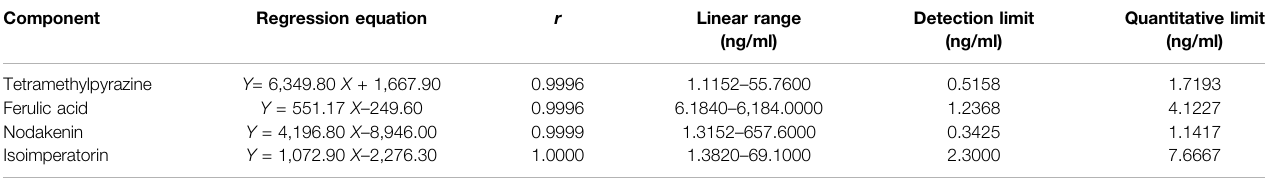
TABLE 4 | Recovery of tetramethylpyrazine, ferulic acid, nodakenin, isoimperatorin in Chuanxiong Chatiao powder. Component